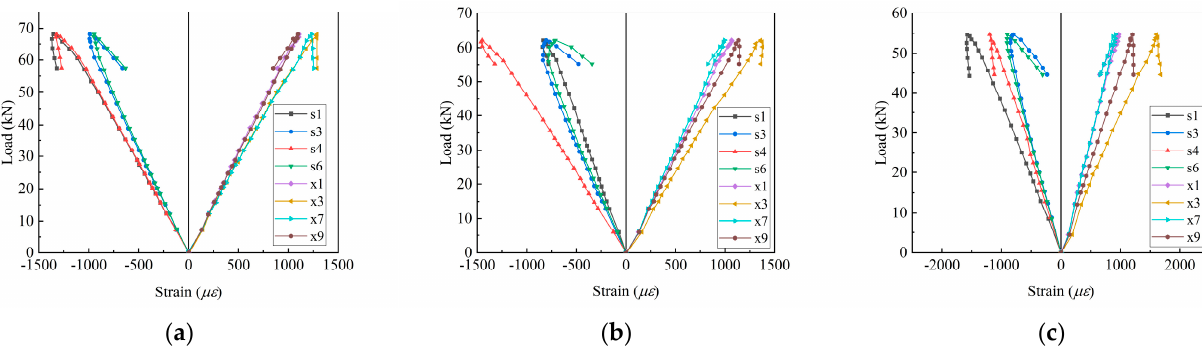
Figure 15. Load–strain curves of the flange: ( a ) Test beam A01; ( b ) Test beam A11; ( c ) Test beam A23.